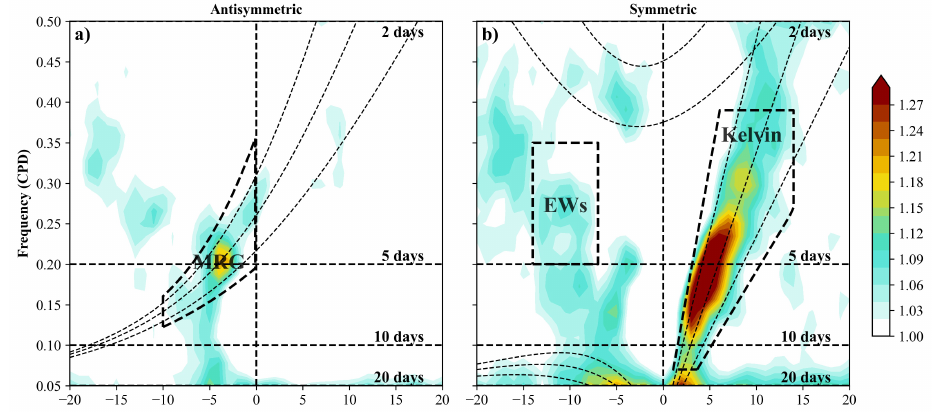
Figure 2. Regional wave number–frequency power spectrum of the ( a ) symmetric and ( b ) antisym- metric component of ERA5 precipitation, plotted as the ratio between raw power and the power in a smoothed red noise background spectrum (see [6] for details). Light dotted lines show the dispersion curves for the Matsuno [54] solutions to equatorially-trapped waves. Boxes represent regions of wave number–frequency filtering for the Kelvin waves, mixed Rossby-gravity (MRG) waves, and Easterly waves